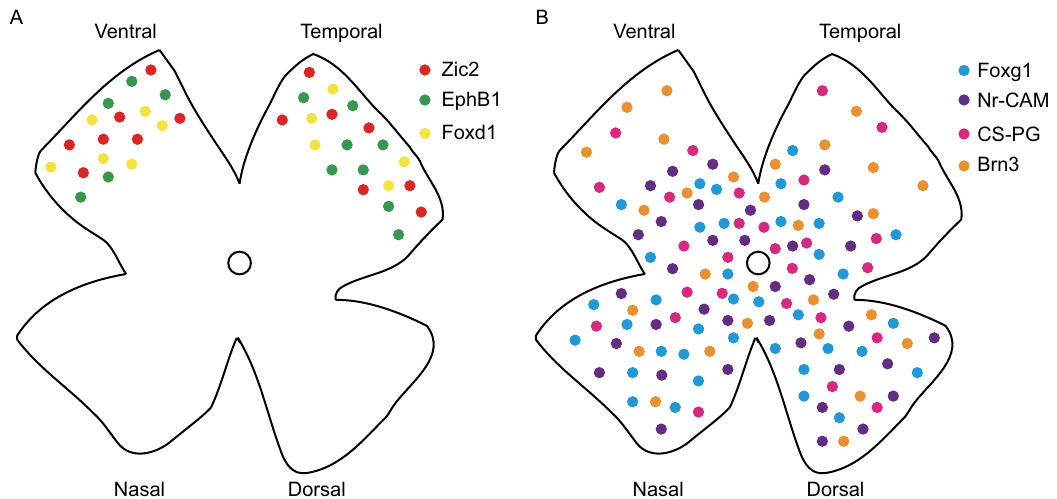
Figure 2. Spatial distribution of the guidance cues in the retina. (A) Molecules expressed in the VT region. (B) Molecules expressed across the whole retina or the complementary territory.